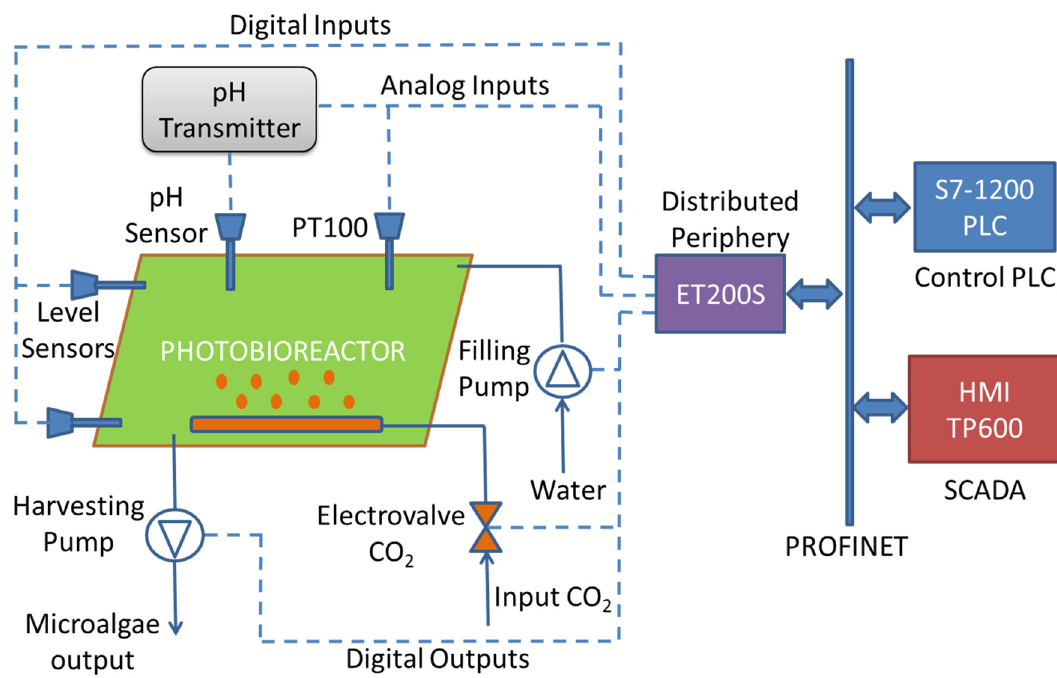
Figure 2. Automation and monitoring system of the pilot plant.